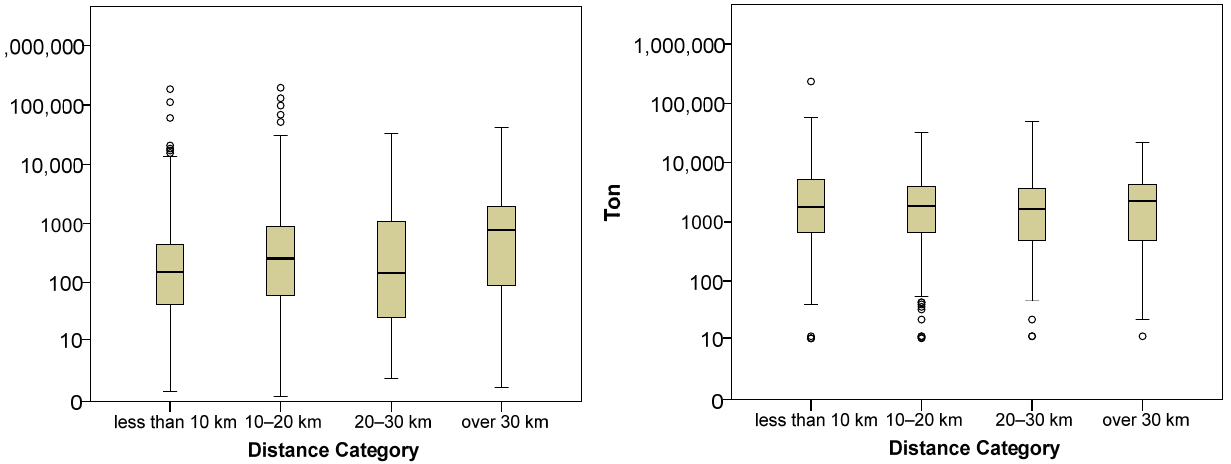
Figure 7. Fill weight in 10 km ranges. Left: Chikiri Island (landfill only, dredging excluded). Right: inland private fill sites.